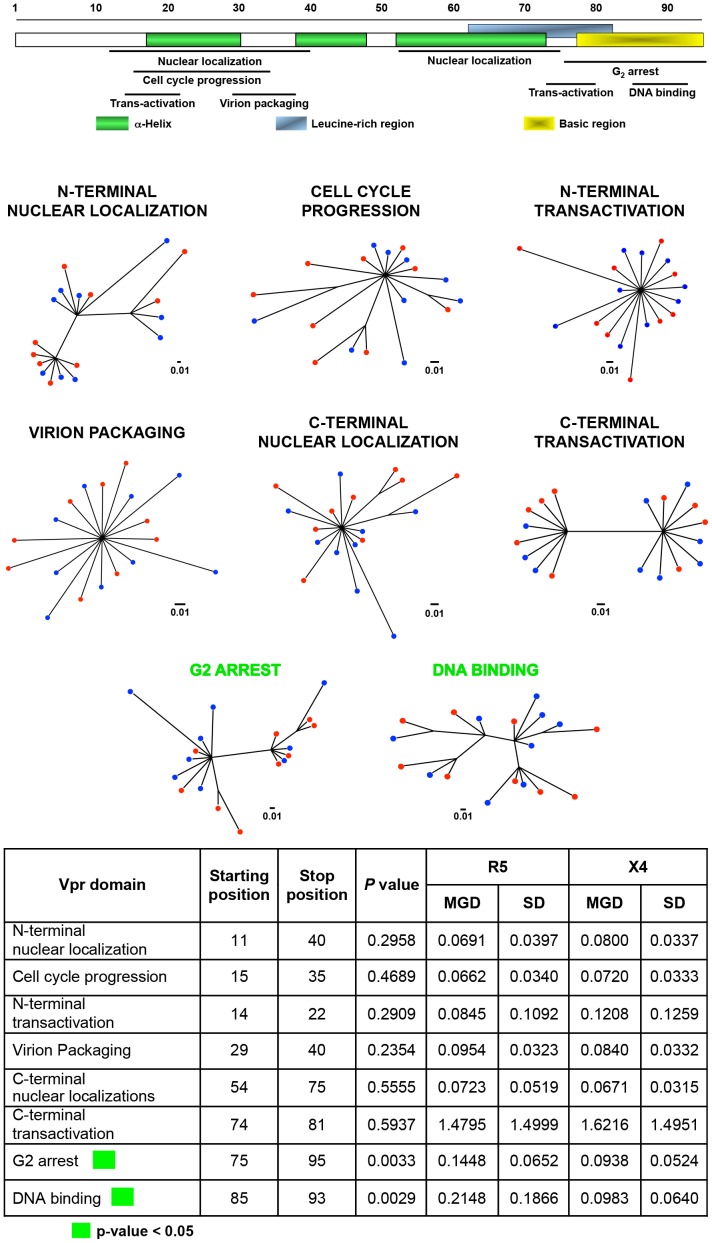
Phylogenetic trees and MGD comparisons of domains of Vpr between selected X4 and R5 sequences.A total 8 domains of Vpr were selected based on the known functional property region. Phylogenetic trees were created from a total 18 sequences, which were included 9 sequence of X4 and 9 sequences of R5, based on maximum likelihood algorithm. A simply Python automated the process of generating the hundreds of trees, and each branch distance was calculated between all pairs of X4 and R5 sequences. These groups of distances were tested for a significant difference using a two-tailed student t-test. The MGD, SD and P value of each group are shown. The two most significant comparisons were shown in green while the two least significant ones revealed in purple.